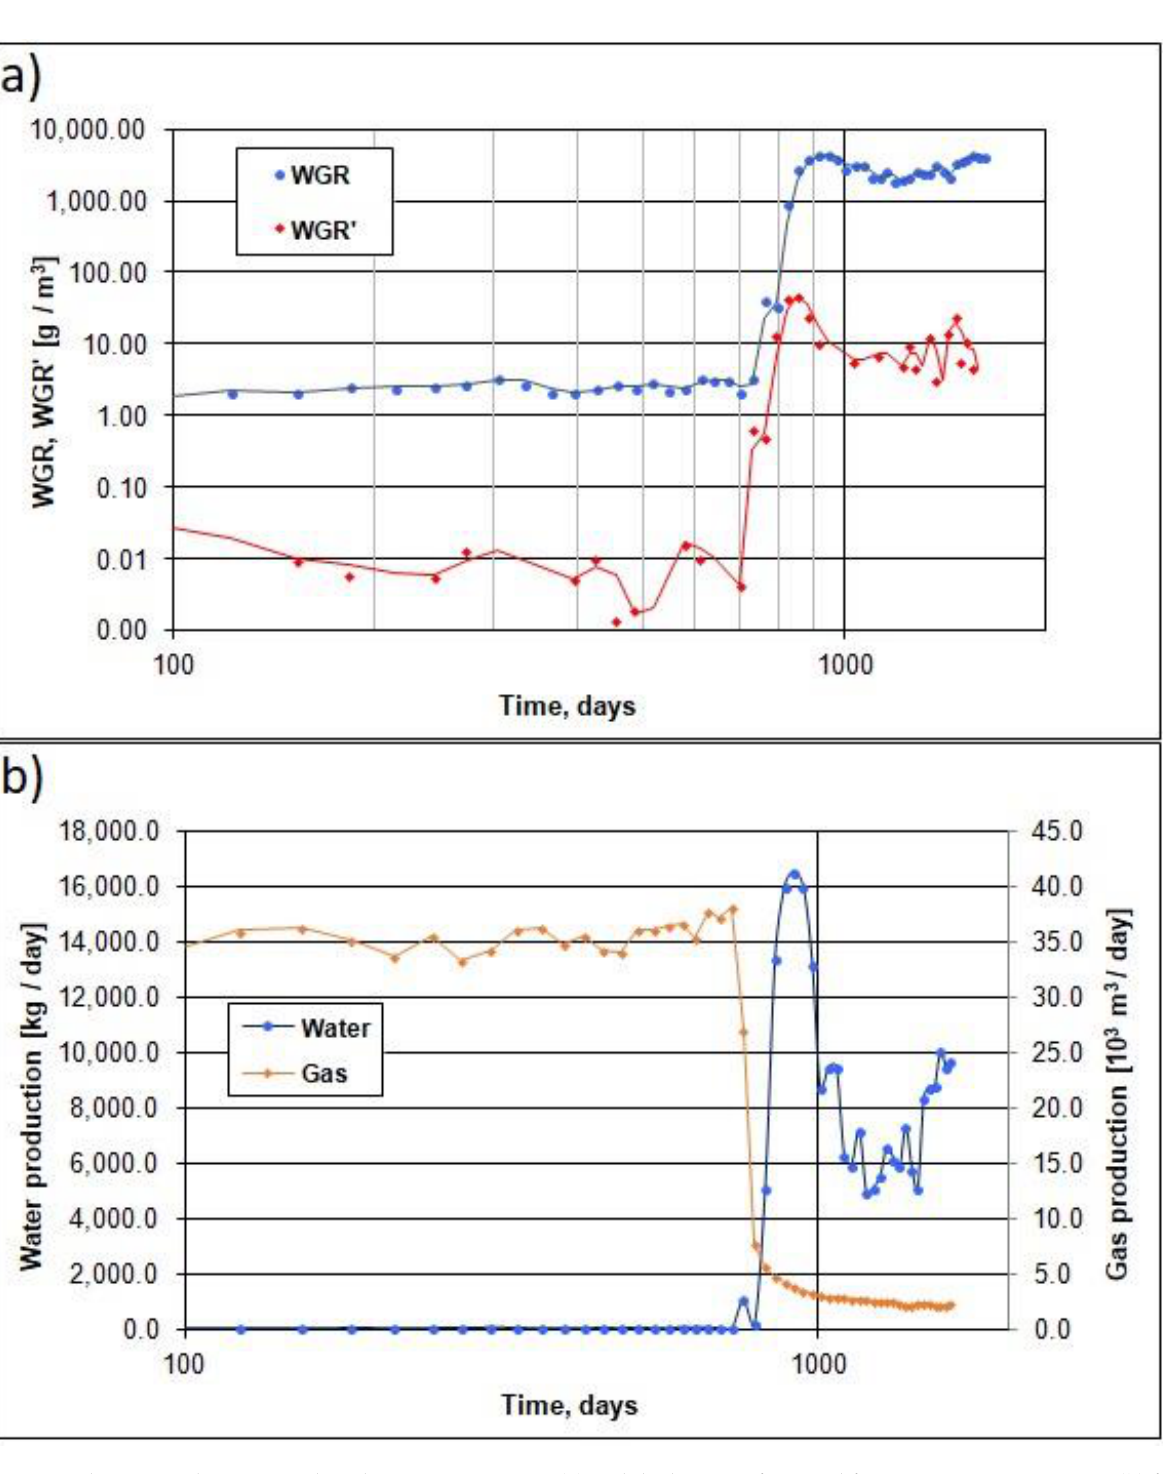
Figure 6. Changes in the WGR and its derivative over time ( a ) and the history of gas and formation water extraction ( b ) for the Z-1K well.